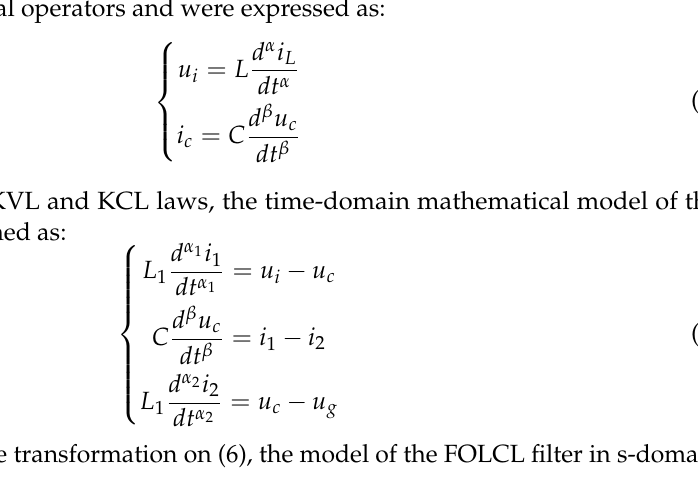
Figure 1. Topology of a fractional-order LCL filter.